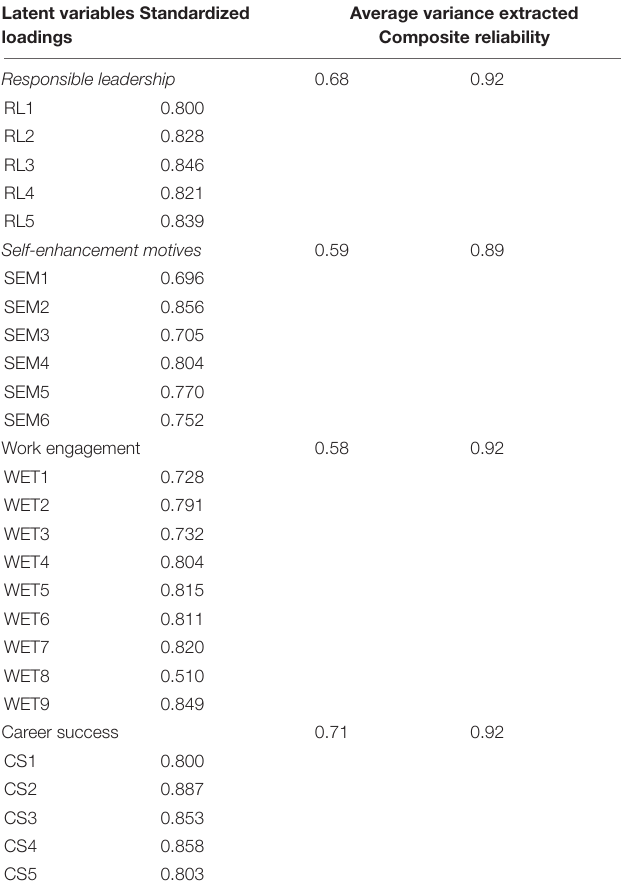
TABLE 1 | Confirmatory factor analysis: Validity and reliability.